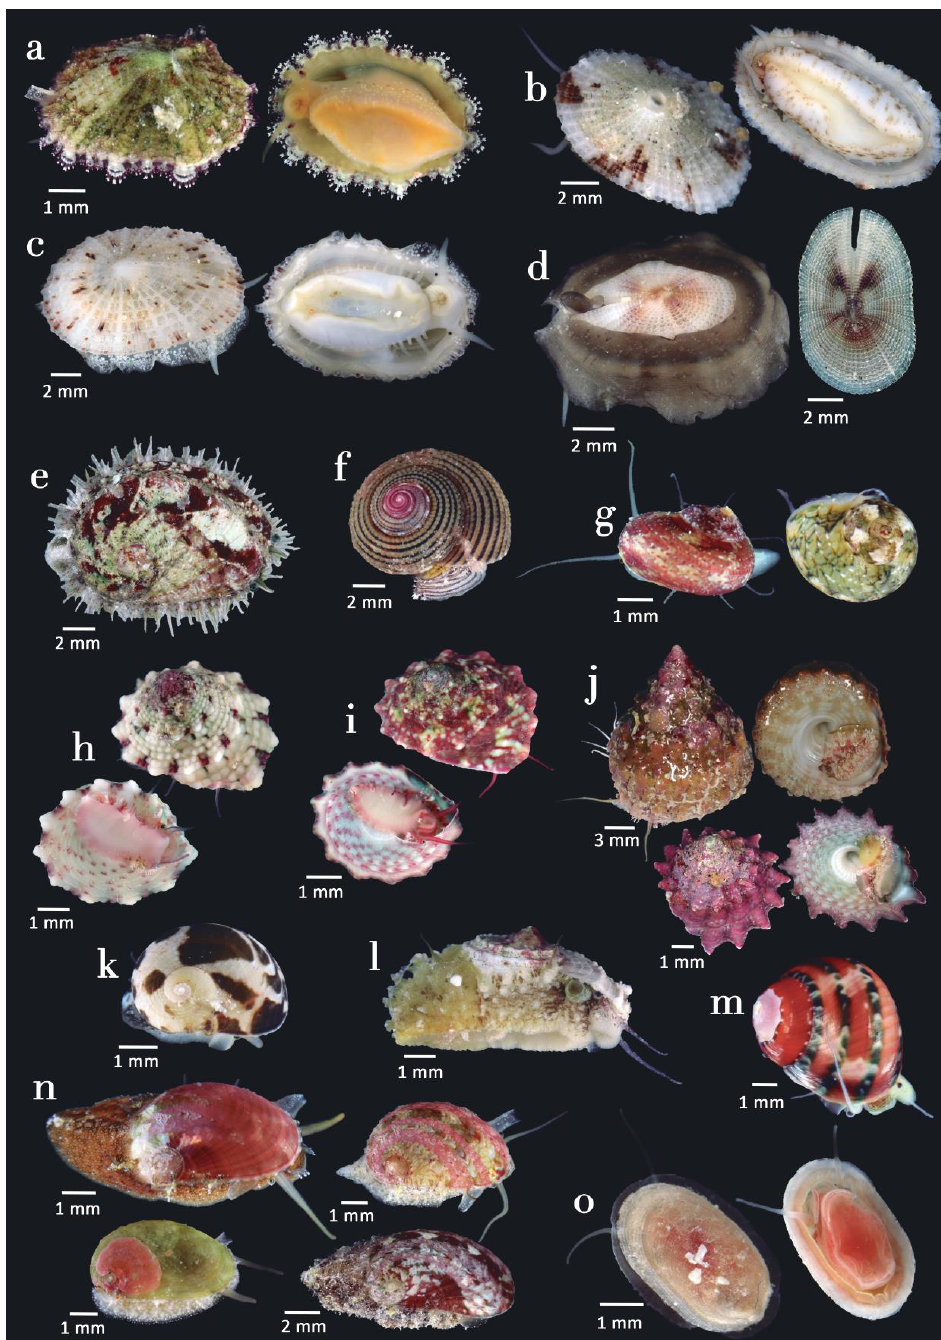
Figure 8. Vetigastropoda: ( a ) Hemimarginula cf. biangulata (dorsal: MCZ:Mala:393769, ventral: